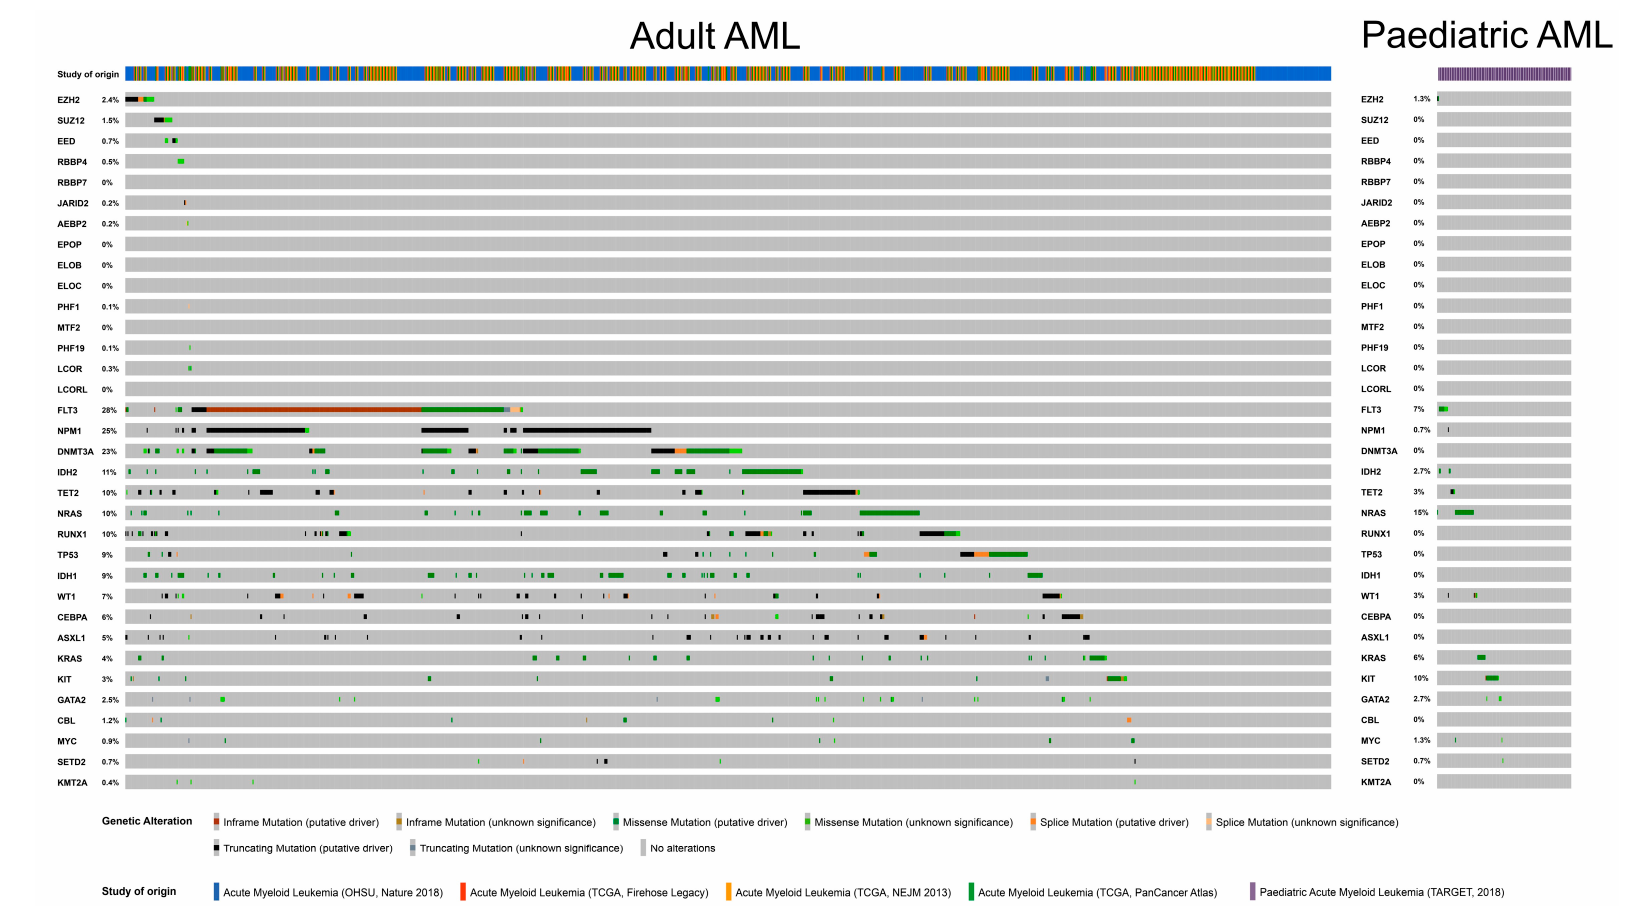
Figure 4. OncoPrint of genetic interactions involving mutations found in adult and paediatric patients with AML. The genes that are frequently mutated in adult and paediatric AML were queried in the Beat AML [35] (study of origin marked as OHSU, Nature 2018), TCGA [52,53] and TARGET 2018 [33] datasets. The genes corresponding to PRC2 factors are listed first, followed by other frequently mutated genes in order of relative frequencies of mutations in adult AML. For visualisation purposes, genes coding for PRC2 factors are shown at the top of these lists, with other AML-associated mutations depicted in descending order of occurrence in adult AML samples. The individual oncoprints with higher image resolution can be found at- https://tinyurl.com/yysensxu (adult AML) and https://tinyurl.com/y7s7xdfa (paediatric AML) and were obtained from OncoPrint within cBioPortal [51] on 19th January